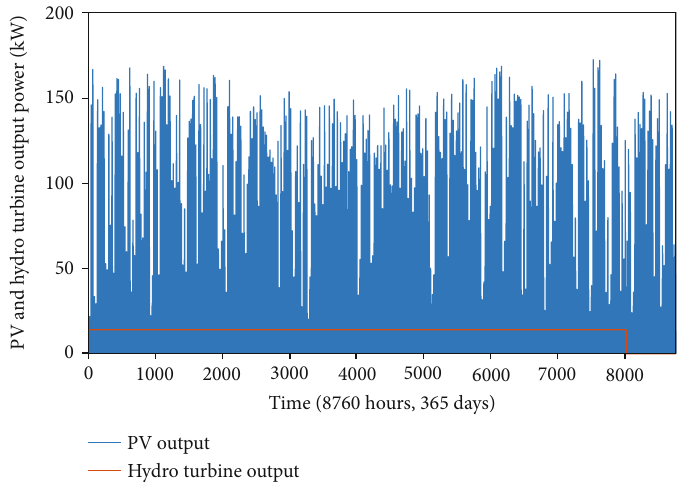
Figure 19: Hybrid PV-hydro turbine power output for the minigrid system.